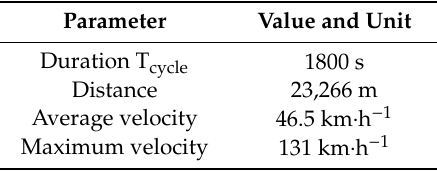
Table A5. Properties of the WLTC Class 3